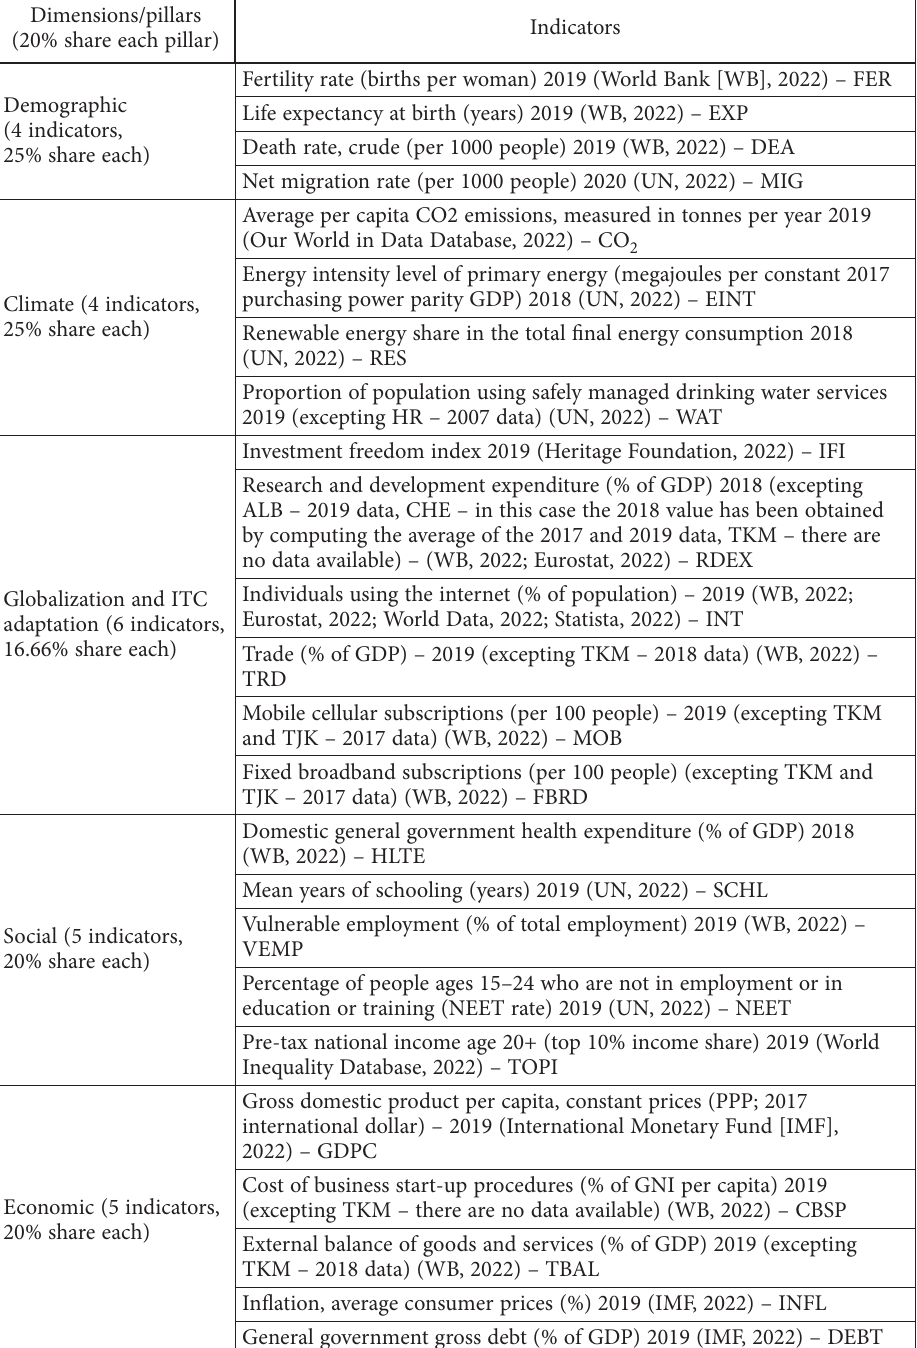
Table 2. Specific indicators for each pillar/dimension (source: own processing) Dimensions/pillars (20% share each